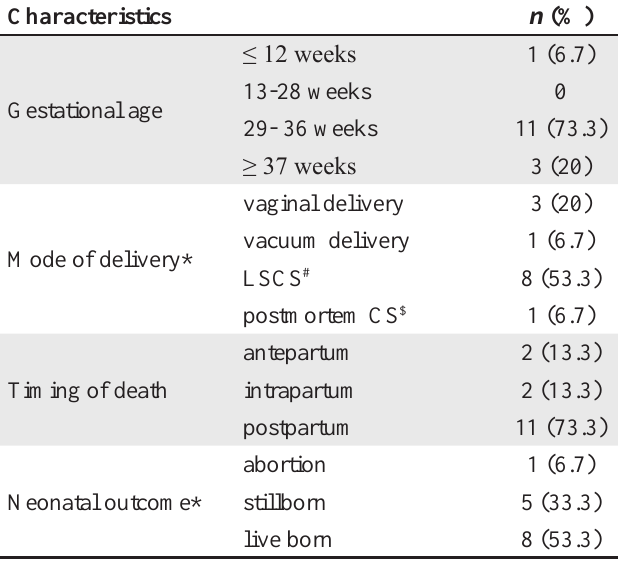
Table 3 : Gestational age, mode of delivery, and time of maternal death and neonatal outcome (N = 15) Characteristics